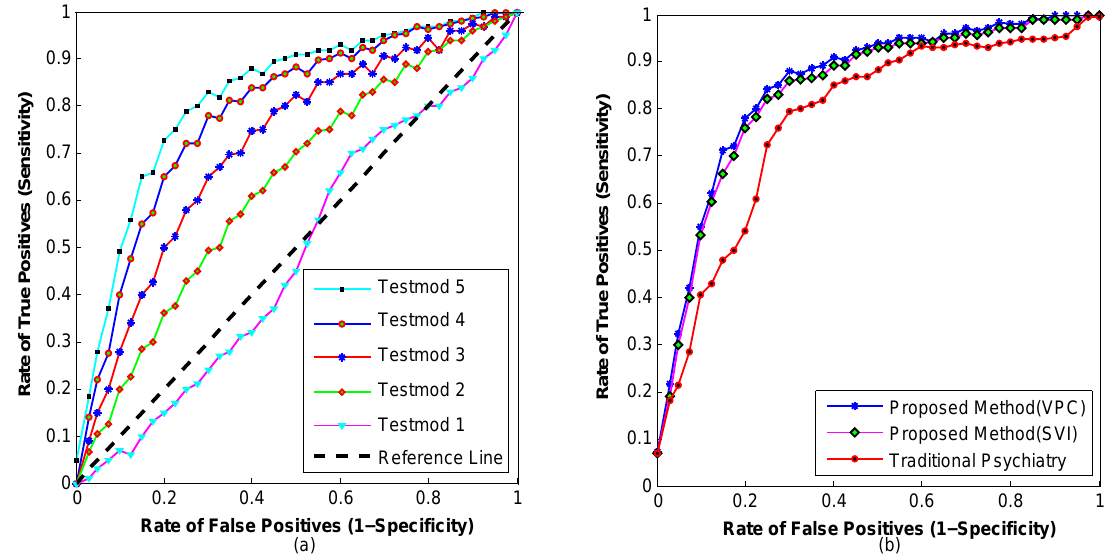
Figure 16. ( a ) Receiver Operating Characteristic (ROC) curves for presenting the true positive rate against the false positive rate of different test settings presented in Table 2; ( b ) ROC curve of psychiatric emergency state prediction using the proposed emergency psychiatry model (VPC and SVI training based) and the questioner-based traditional psychiatry model.